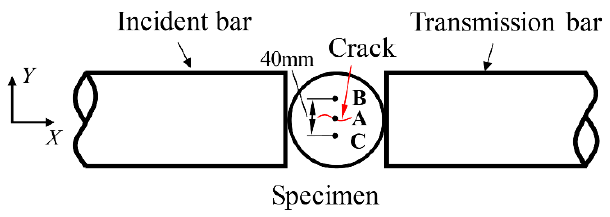
Figure 6. The position of points A, B, and C in the concrete specimen.